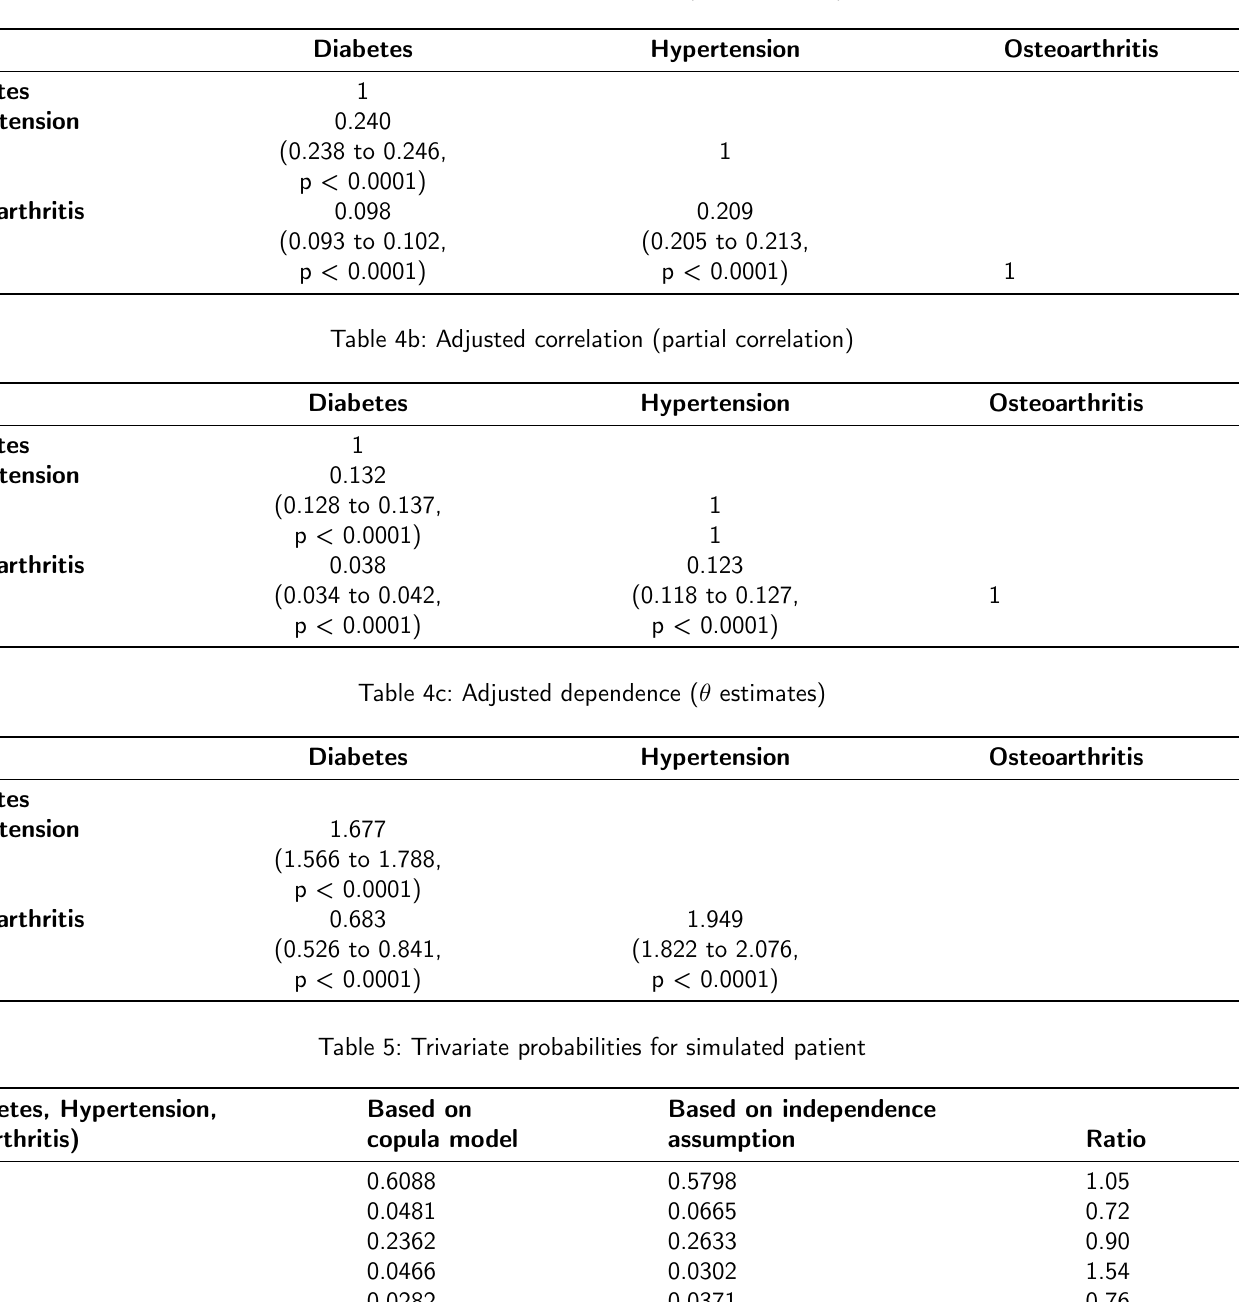
Table 4a: Unadjusted correlation ( φ coefficients)